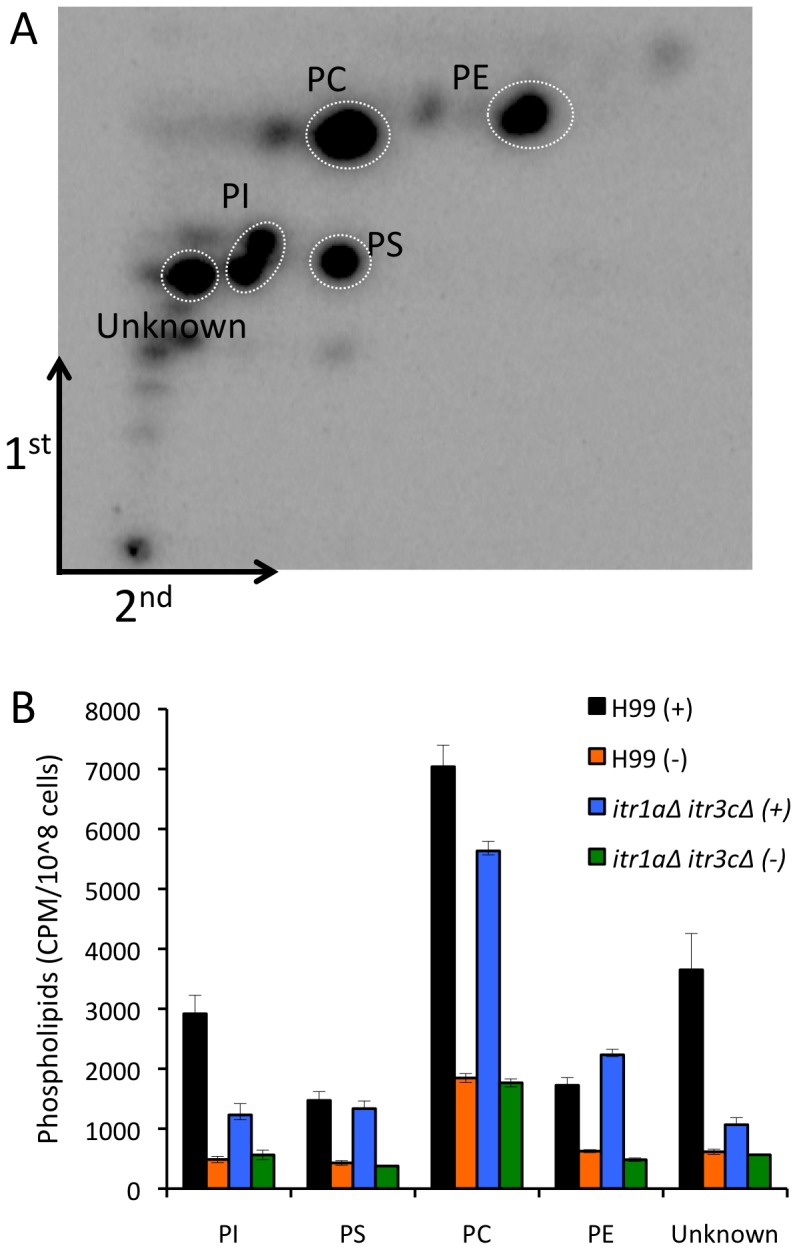
Inositol treatment changes phospholipid composition.Major phospholipids were examined by 2-dimensional thin layer chromatographic (2D-TLC) separation. H99 and the itr1aΔ itr3cΔ double mutant were steady-state labeled with 32Pi and grown on SD medium without or with 5 mM inositol for 20 hrs before cells were collected for lipid extraction. (A) A representative image of 2D-TLC results of H99 treated with inositol is shown. Five phospholipid species were labeled. (B) Quantification of phospholipid composition of Cryptococcus wild type H99 and the itr1aΔ itr3cΔ double mutant without or with inositol treatment. Abbreviations: PI, phosphatidylinositol; PC, phosphatidylcholine; PS, phosphatidylserine; PE, phosphatidylethanolamine; Unknown, one unidentified lipid species. Error bars indicate standard deviations.